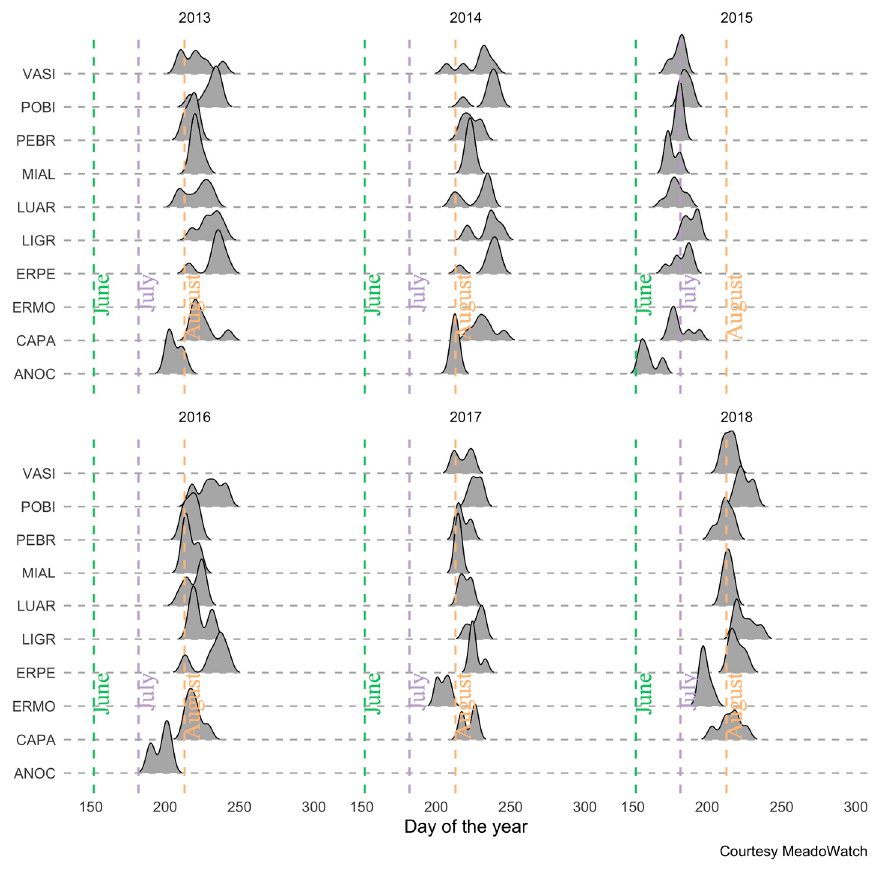
Figure 2. In-situ observed flowering of 10 of the most abundant meadow species across a 6-year period (2016 shown for completeness). The dotted lines indicate start of the month. Species include Valeriana sitchensis (VASI), Polygonum bistortoides (POBI), Pedicularis bracteosa (PEBR), Microceris alpestris (MIAL), Lupinus arcticus (LUAR), Ligusticum grayi (LIGR), Erigeron peregrinus (ERPE), Erythronium montanum (ERMO), Castilleja parviflora (CAPA), Anemone occidentalis (ANOC). Flowering windows were estimated using flowering observations by the MeadoWatch program and those reported in Theobald et al. (2017). In both the cases, observer(s) recorded the species, the date (day of the year) and flowering status (‘yes’ or ‘no’) in multiple plots (plots measured 1 m × 1 m in Theobald et al. 2017 and were estimated at ~2 m × 1 m in MeadoWatch). The main difference between these datasets is that multiple 1 m × 1 m plots were sampled within one of five meadows sites by Theobald et al. (2017), whereas sampling occurred at nine single MeadoWatch plots, along a prominent hiking trail. MeadoWatch plots were close to the five Theobald sites, and spanned the same elevation gradient. Plots within the Theobald et al. (2017) sites were combined to delineate an area (purple polygons in Figure 1) to fetch the satellite imagery. For the purposes of this study, the MeadoWatch plots were grouped by elevation using the shortest distance to nearby Theobald site (Figure 1). Once grouped by elevation, the observations were then separated by year to calculate mean and standard deviation (SD) of peak flowering day (Figure 3A). The days in one ± SD of the mean was considered to be peak flowering window for that year and elevation (Figure 3B). Our determination of flowering windows assumes that all 10 focal species are found in all plots in all years. This is not a valid assumption but making it does not bias our conclusions as we are making inference at the community-level. In other words, we are determining peak flower as the date at which there is the highest probability of seeing any species in flower and are using the 10 most prominent and abundant species to make this